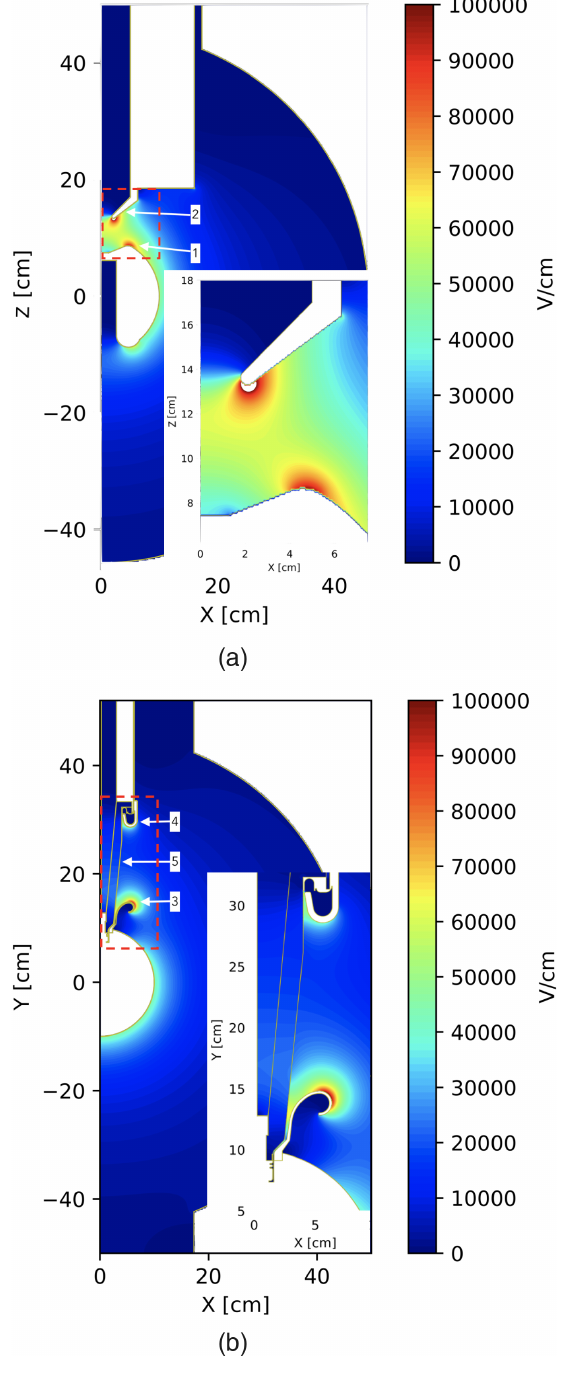
FIG. 3. The field gradient of the HVDC gun. The most important parts as dashed red boxed are zoomed in. The main high gradient locations are labeled: 1: Pierce nose; 2: anode; 3: HV trip-point shield; 4: grounded trip-point shield; and 5: ceramic. (a) The field gradient map on the dc gap. (b) The field gradient on the HV ceramic feethrough. can offset the laser 9 mm or with a large laser size of 9 mm in radius with increasing initial normalized emittance no more than 25% [26].